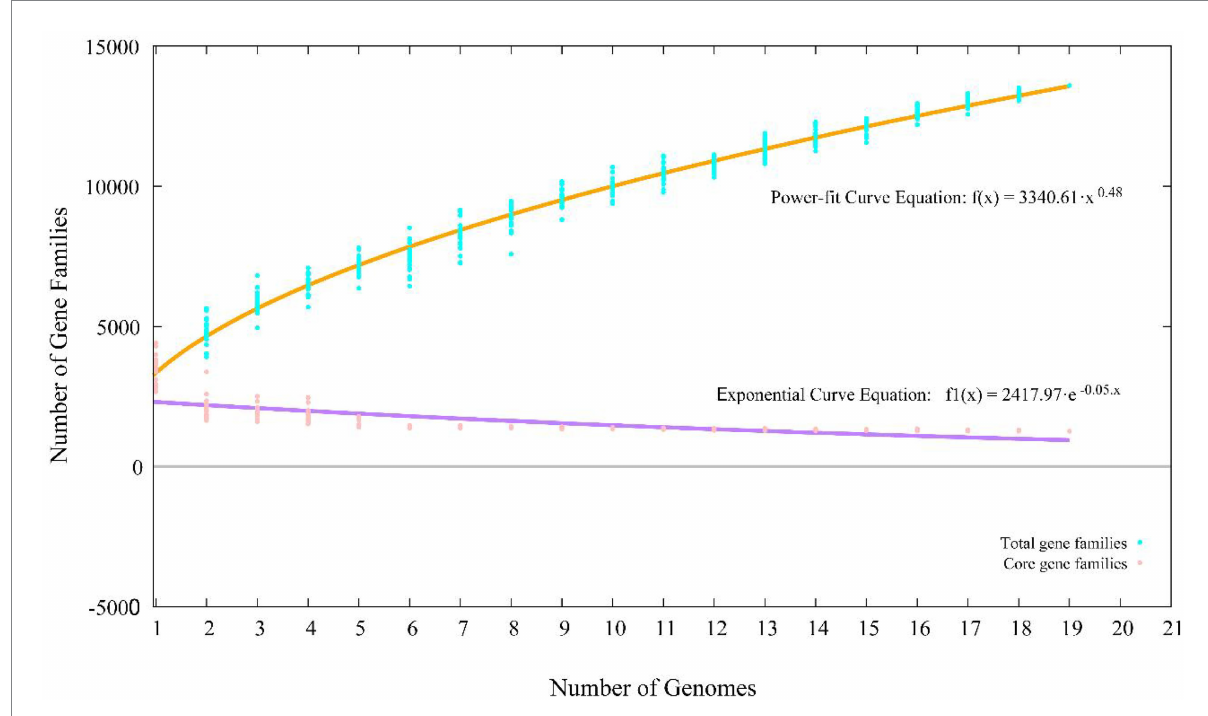
FIGURE 2 Pan-core plot of the genomes of CPCC 101365 T , CPCC 101269 T , CPCC 101426, and other 16 type strains of the genus Stenotrophomonas . x axis shows the number of genomes while the y axis represents the number of gene